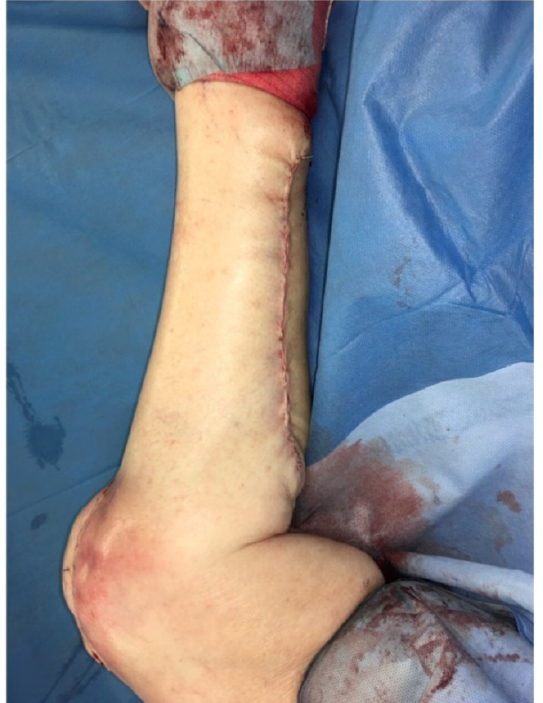
Figure 17: Pedicled MSAP gastrocnemius flap: Intraoperative view of the medial left knee after direct closure of the donor site. The flap integrates nicely into the defect and shows little bulk, which will diminish over time, as the muscle will atrophy significantly. In elderly patients, the laxity of the posterior skin of the calf allows direct closure of the donor site more easily (Table 1: Patient No. 5; additional Figures 6, 12, 13, 14, 15,